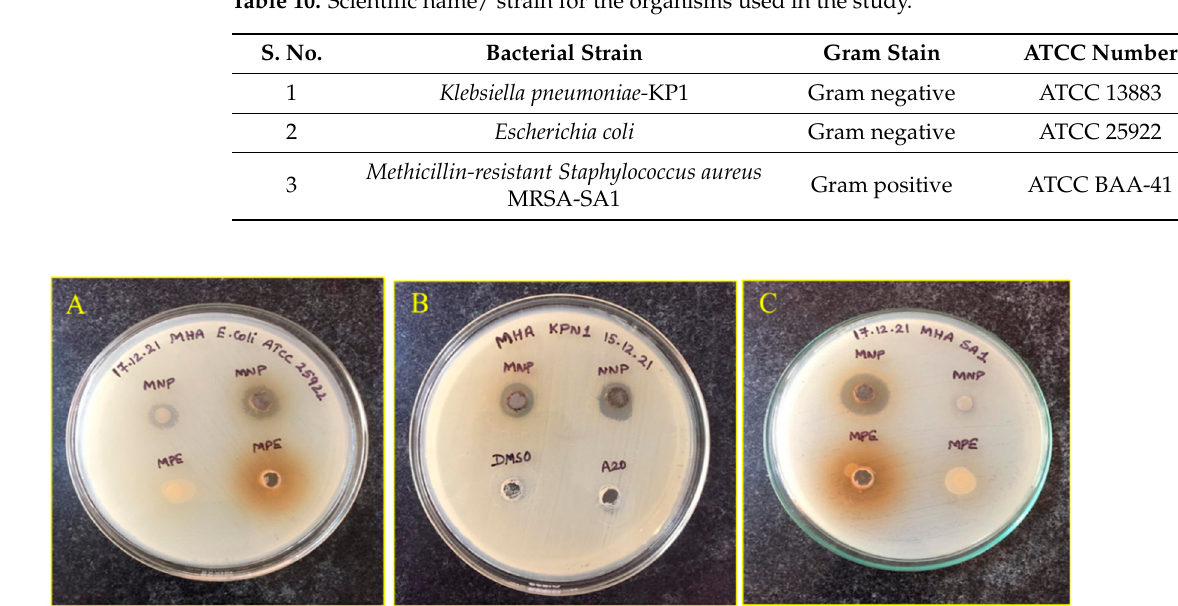
Figure 5. Zone of Inhibition (visible clear zones) produced by MNP against clinical MDR pathogens: ( A ): E. coli ATCC 25922 ( B ) K. pneumoniae KP1 and ( C ): Methicillin Resistant S. aureus (MRSA-SA1).